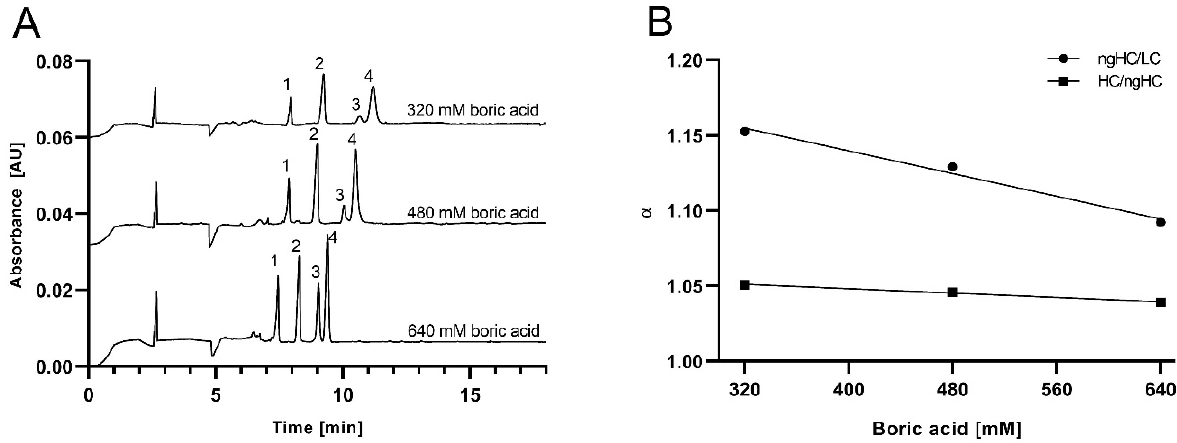
Figure 4. Separation of the SDS-omalizumab subunit complexes in 1% agarose gels with increasing TBE background electrolyte concentrations ( A ). The selectivity changes as the function of boric acid concentration between the ngHC/LC and HC/ngHC fragments are shown in panel ( B ). Peak assignment and separation conditions were the same as in Figure 1.